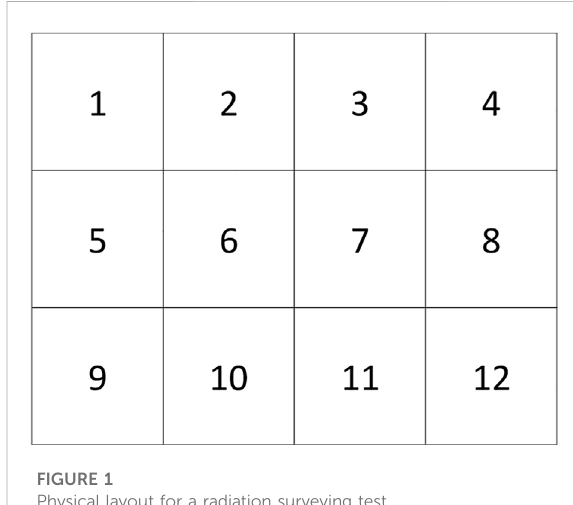
FIGURE 1 Physical layout for a radiation surveying test.